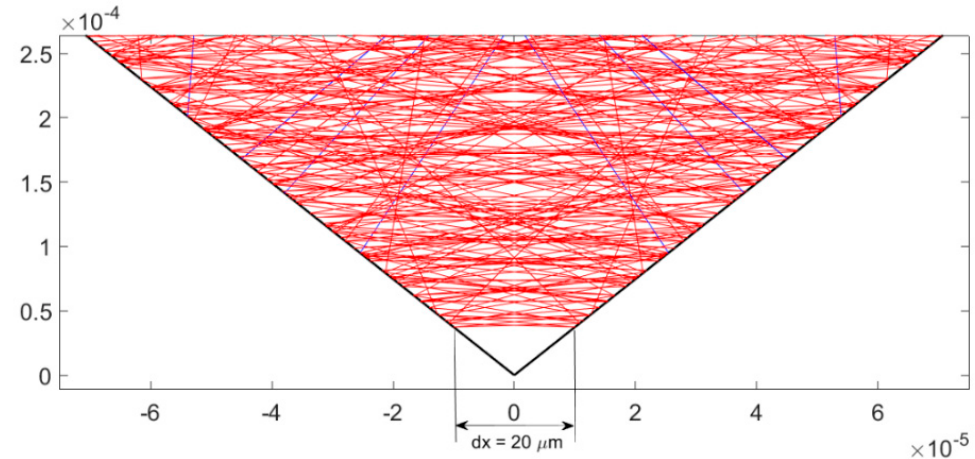
Figure 3. Ray tracing diagram showing the minimum width in the V-cavity. Homogeneous, isotropic materials with a perfectly defined chemical composition are considered. The separation surface between the media is considered optically smooth. The energy propagation medium between the reflecting and collecting surfaces is not diffusive. These conditions are ideal; they allow us to determine the influence of the optical properties of complex and real index materials on the radiative properties. Several functions were implemented to determine the intersections, angles, and reflection coefficients of the reflected rays inside the V- cavity; the sides of the V-cavity are treated as two flat surfaces forming an angle φ . The sides of the cavity are discretized into different facets. Simulations of the emitted and reflected rays inside the groove are done by choosing a large width with respect to the wavelength (a minimum ratio dx / λ = 10 for the study case considering infrared wavelength of 10 µ